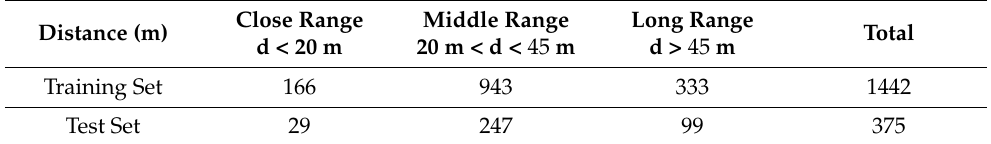
Table 2. Distribution of the number of vehicles labeled in the Tusimple dataset.